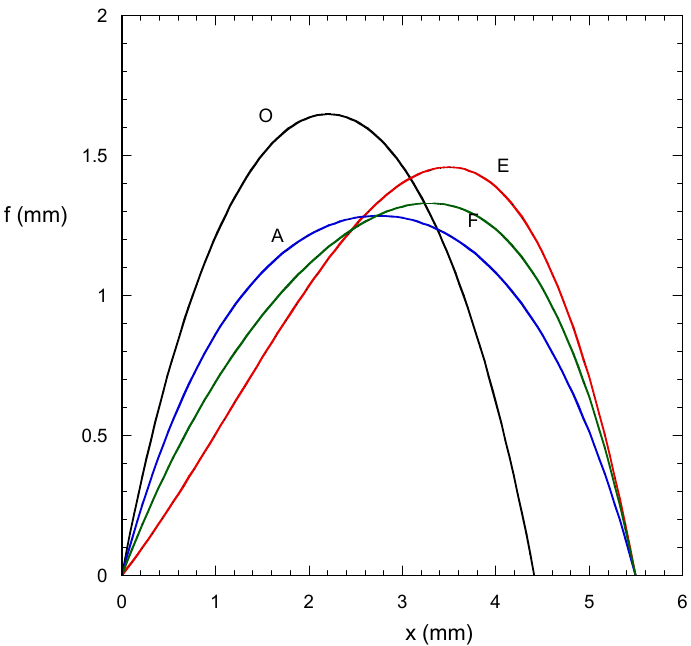
Figure 10. Droplet profiles at different positions along the blue (left) stepwise trajectory in Figure 9 (V A = 5 mm 2 , θ a = 60°, θ o = 60°, Bo N = C N /2.5).